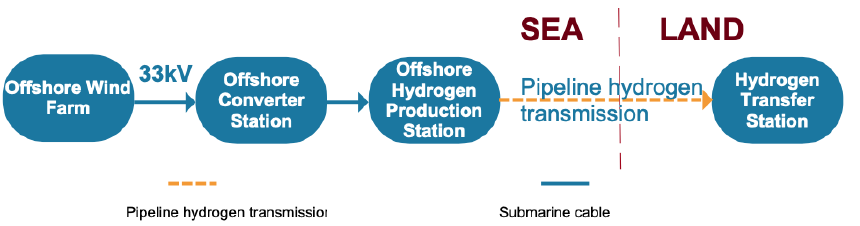
Figure 7. Topology of an offshore platform hydrogen production and pipeline hydrogen transmis- sion system.